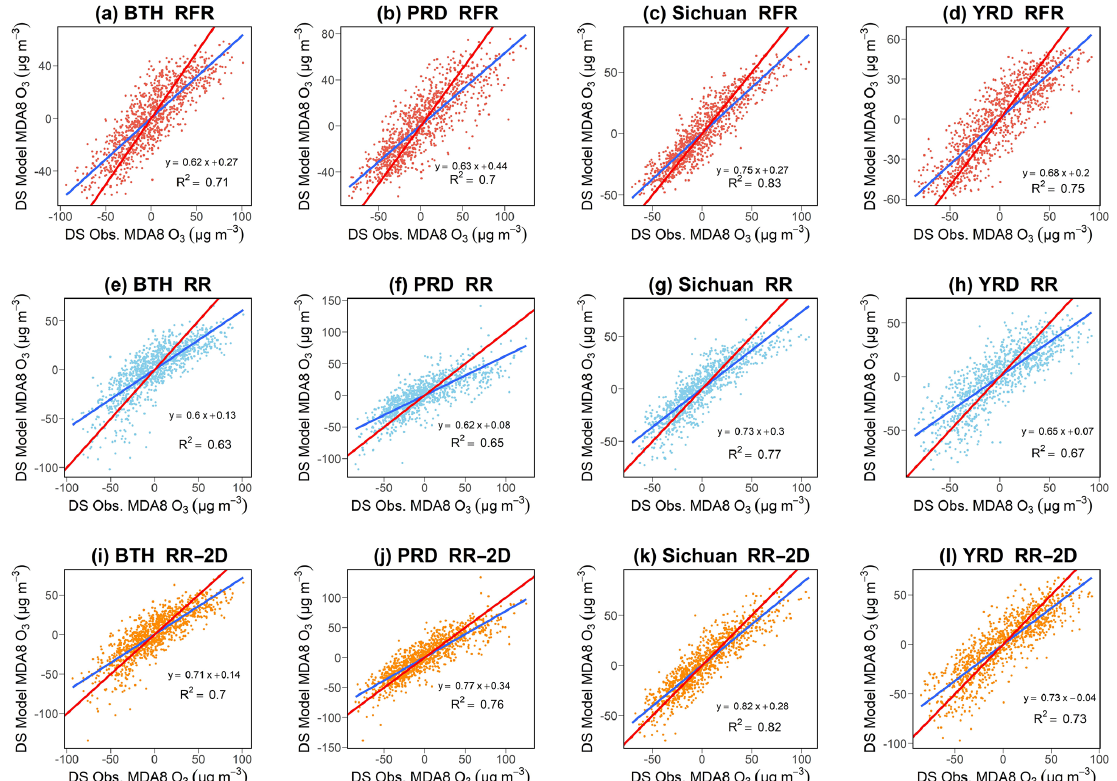
Figure 4. (a–d) Comparison of regional averages of deseasonalized MDA8 ozone between model predictions and observations for RFR, (e–h) RR and (i–l) RR–2D. Linear fits between predicted and observed data are indicated by blue lines; red lines are the ideal 1:1 lines. The values for both models and observations are averaged over all ERA5 grid points in each region. Each graph contains information of the linear regression with slope and R 2 value (coefficient of